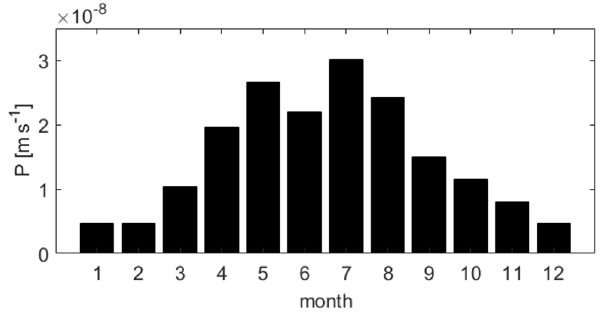
Figure 7. Net inflow used for the 2D flow